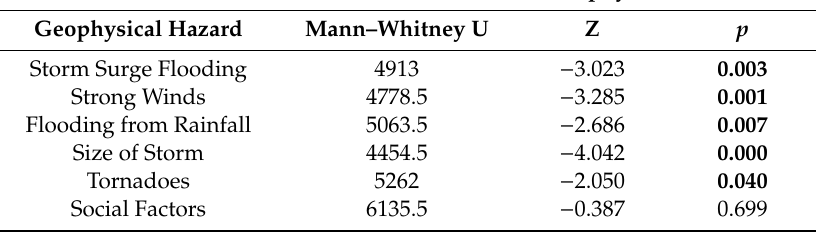
Table 3. Mann–Whitney U test results comparing the Stay-at-Home group to the Evacuation group during Hurricane Irma for geophysical hazards with surge, winds, storm size, and tornado threat as